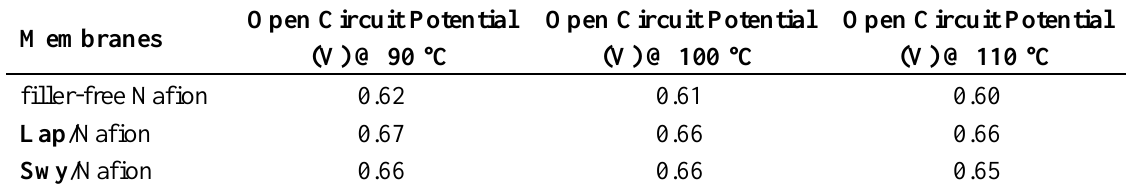
Table 3. Open circuit potential (OCP) values at the different temperatures for the various